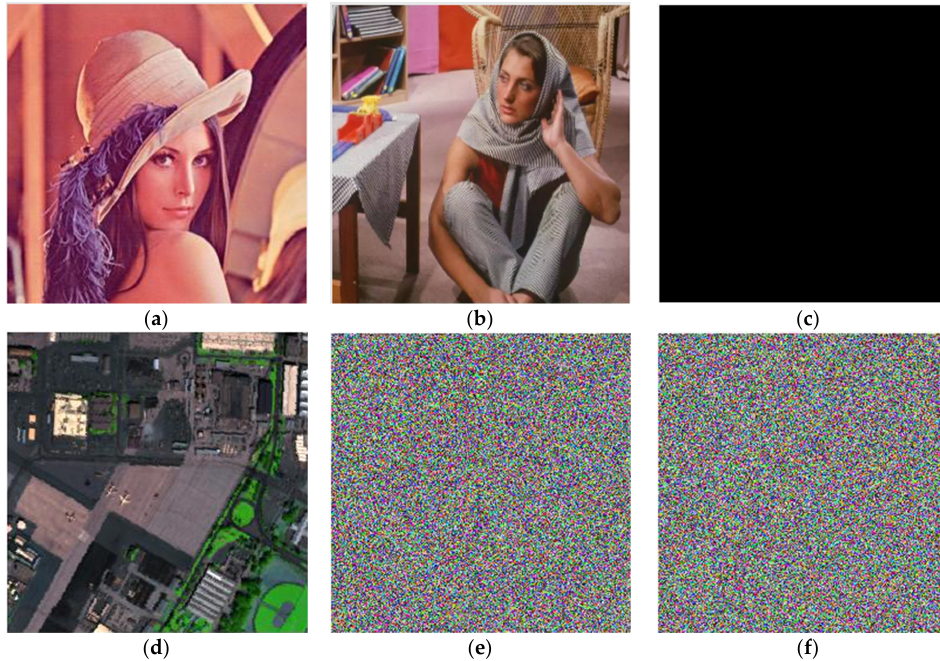
Figure 14. ( a ) image signature of ‘Lena’; ( b ) image signature of ‘Barbara’; ( c ) image signature of all zero; ( d – f ) the corresponding encrypted data.